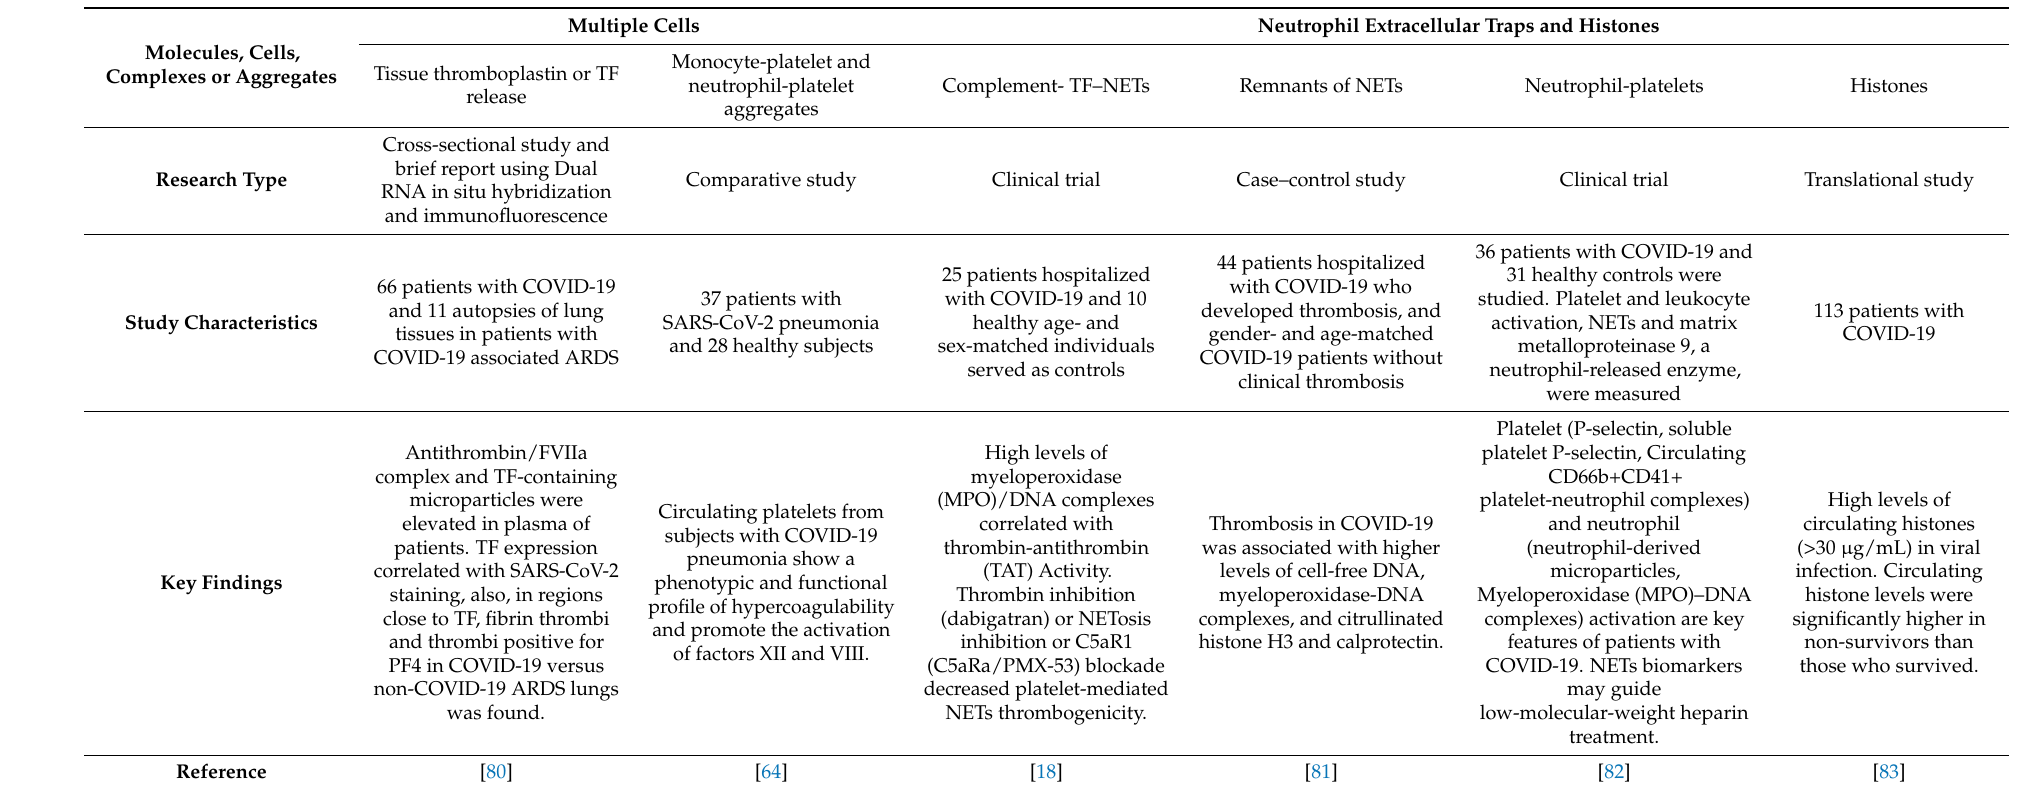
Table 1. Molecules, cells, complexes, or aggregates of importance in the generation of hypercoagulability and